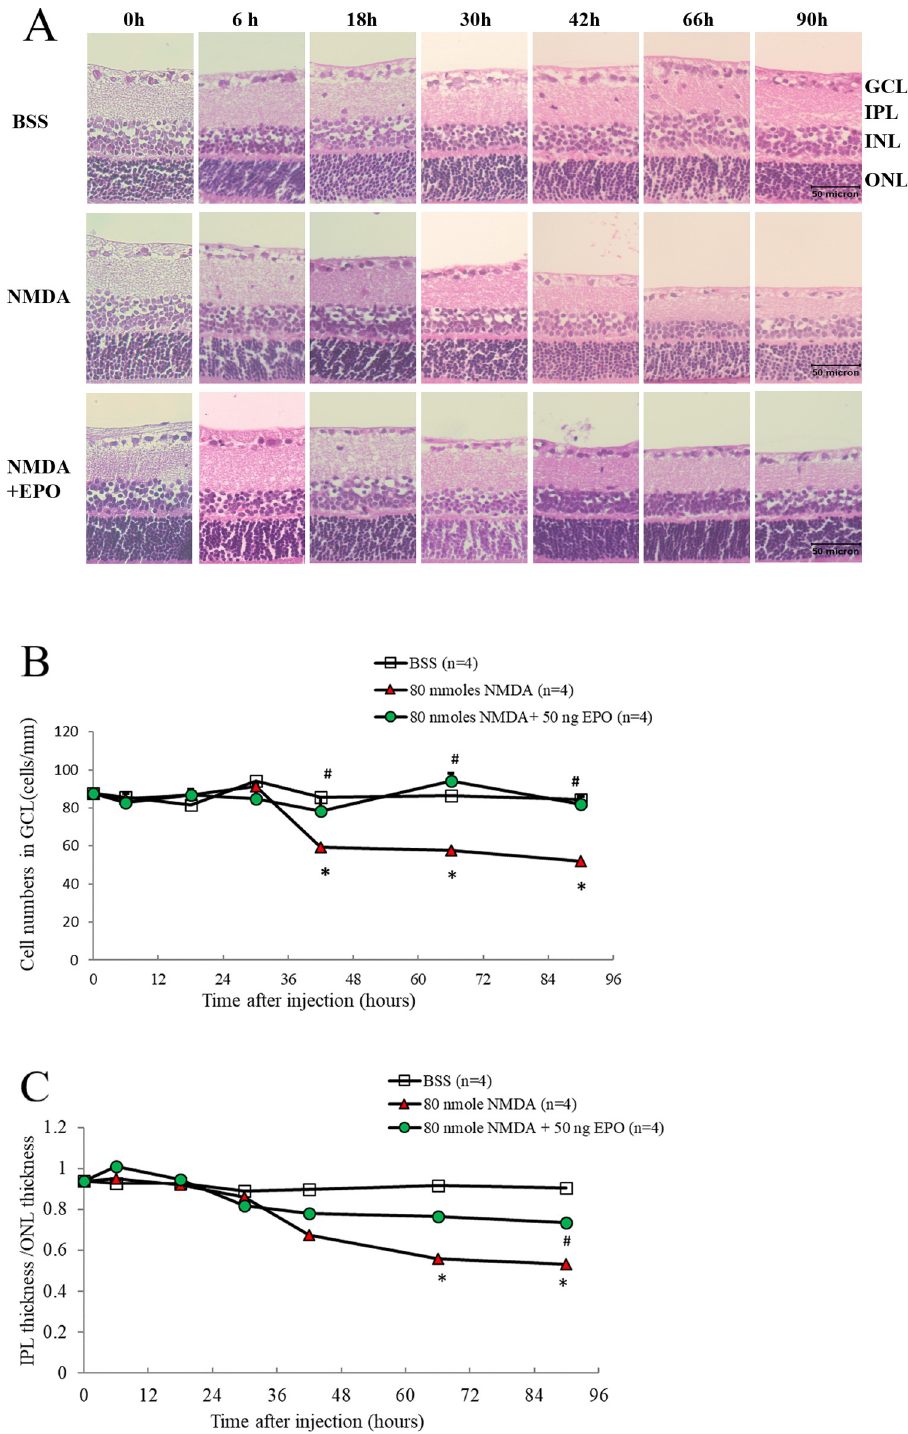
Fig 4. The positive RGC cell number in ganglion cell layers (GCL) and the ratio of IPL/ONL were obtained at different analyzing time on Wistar rats: The median of positive RGC in GCL and the ratio of IPL/ONL of Wistar rats were obtained at 0, 6, 18, 30, 47, 66, and 90 hrs after receiving the intravitreal injection of (1) 2 μ L BSS only, (2) 80 nmoles NMDA, and (3) 80 nmoles NMDA + 50 ng EPO (A). The median of positive cell in GCL (B) and the ratio of IPL/ONL (C) were represented (n = 4), compared to baseline levels ( � p < 0.05) and compared with NMDA-mediated group (#p < 0.05), Bar = 50 μ m.